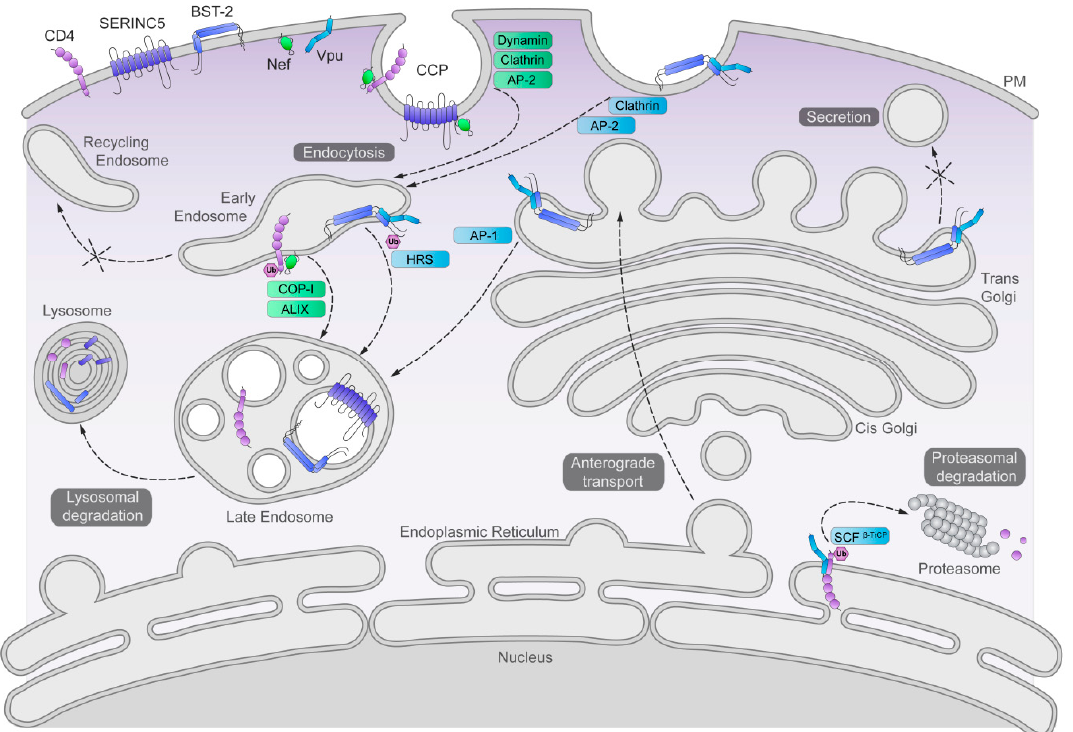
Figure 3. Cell biologic schematic of protein quality control and membrane trafficking pathways co-opted by Vpu and / or Nef. Vpu and Nef, their targets—CD4, SERINC5, and BST-2—and their co-factors—the SCF-E3 ubiquitin ligase, clathrin, AP-1, AP-2, Dynamin, HRS, ALIX, and β -COP—are indicated. Complexes of Vpu with CD4 or BST-2, and Nef with CD4 or SERINC5, are shown. Arrows indicate direction of transport. CCP: clathrin-coated pit; PM: plasma membrane; Ub, ubiquitin. Details of the illustrated pathways are in the text.